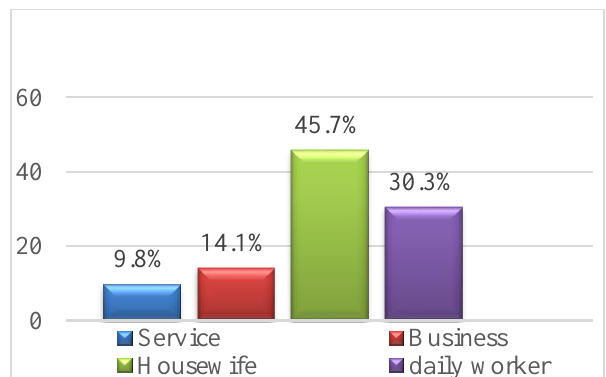
daily Fig-4: Distribution of injured children by mothers occupation, n=212 Fig-4 shows distribution of mothers occupation of injured children where 97(45.8%) were housewife, 65(30.7%) were daily worker, 27(12.7%) were business women, the rest 23(10.8%) were in service.